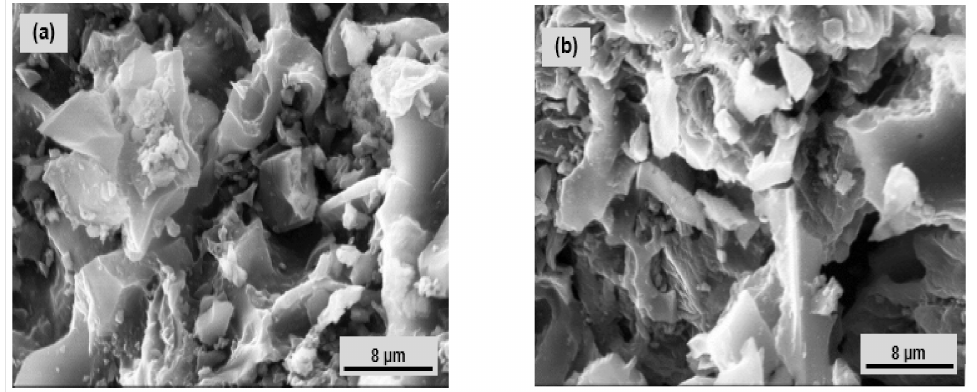
Figure 4. SEM micrographs of: ( a ) Nat-Talc, and ( b ) TalcNH 2 .